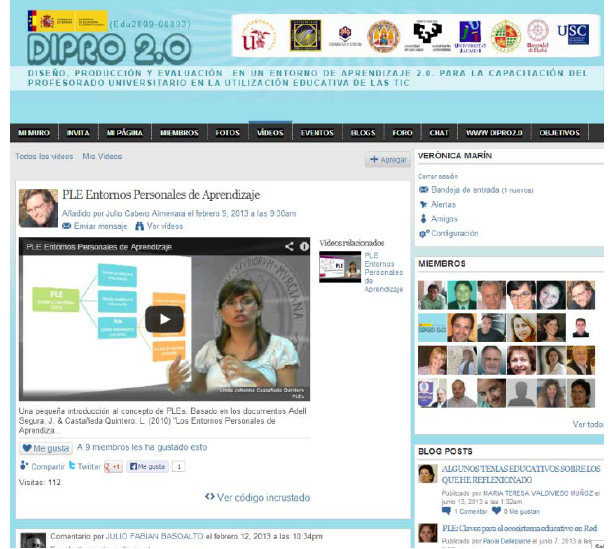
Figure 3 . DIPRO 2.0’s